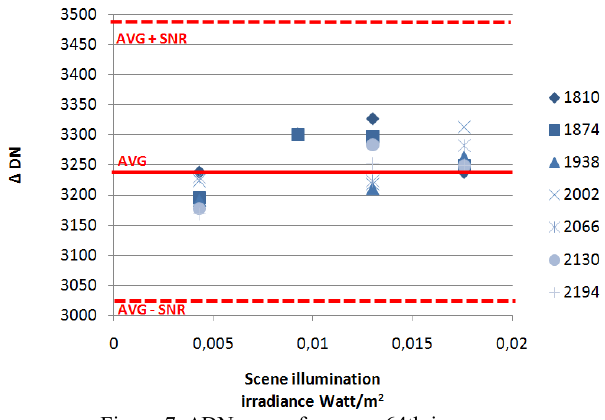
Figure 7. ∆ DN errors for every 64th image.